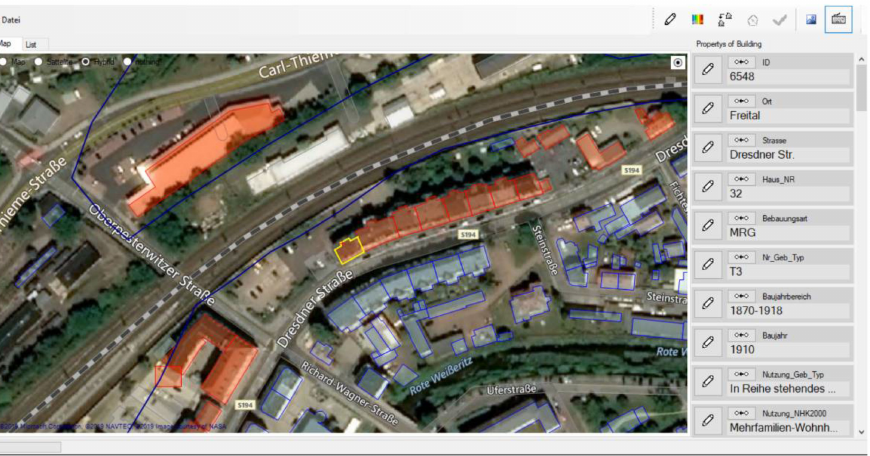
Figure 2. EDAC EQUIP survey tool for the documentation of building parameters (with background maps from Bing Maps ®